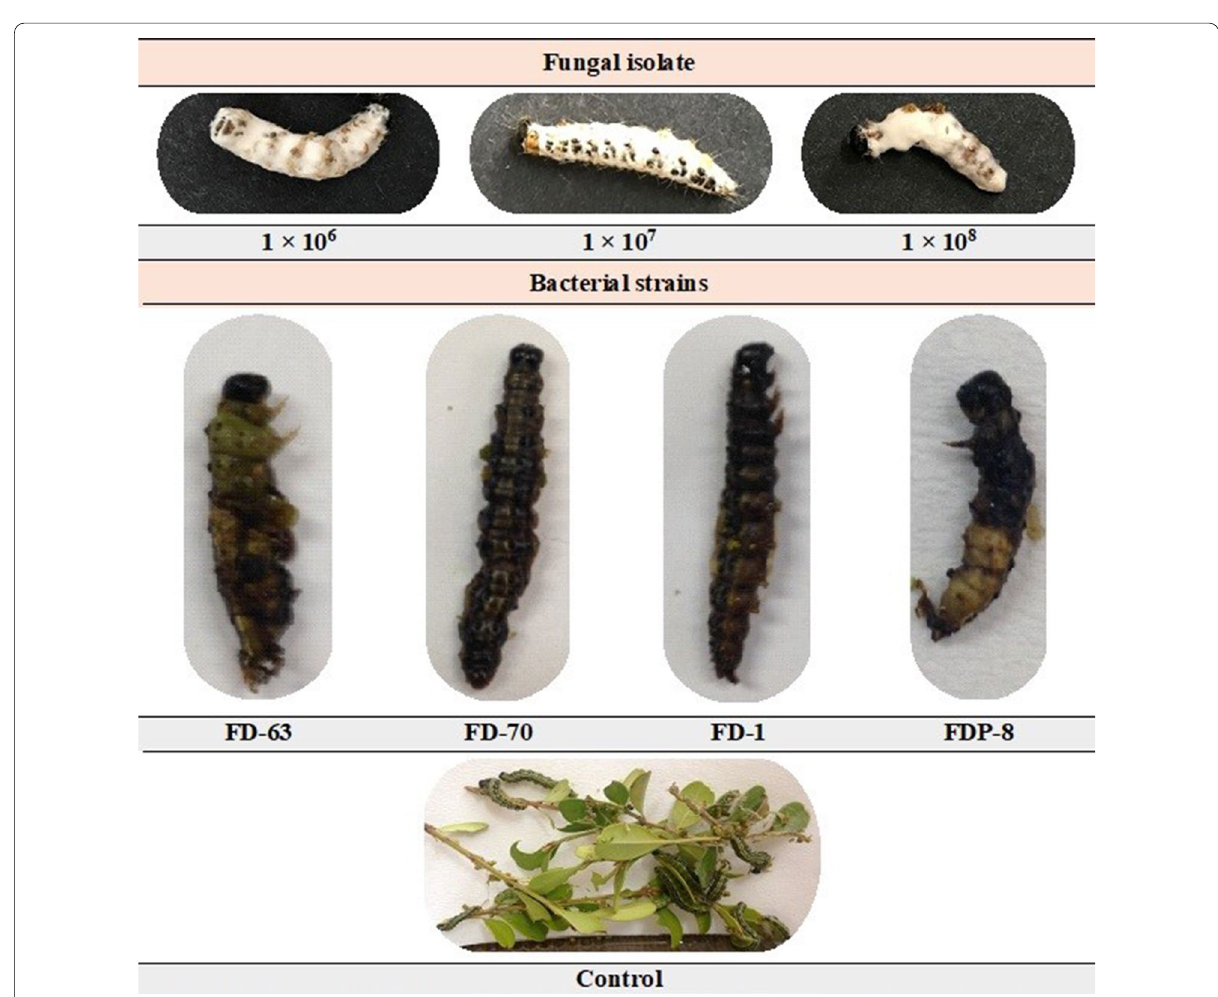
Fig. 2 Pathogenic effect of fungal isolate (three different concentrations) and bacterial strains on Cydalima